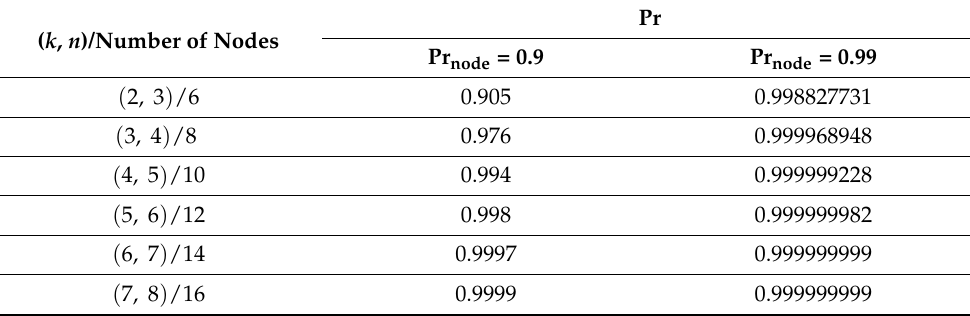
Table 2. Probability Pr of secure data transmission at different numbers of routes and the total number of nodes.